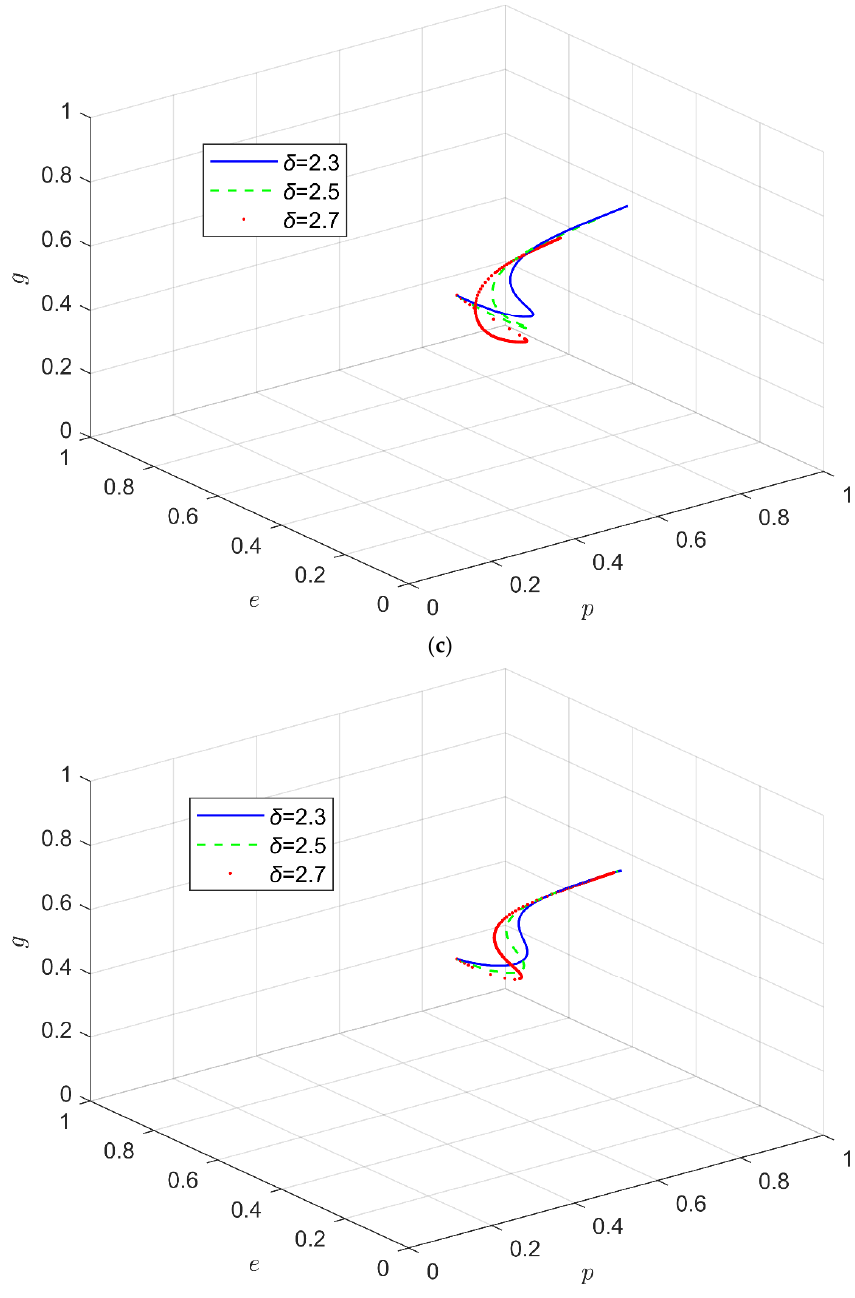
Figure 5. ( a ) Influence of loss avoidance coefficient on system evolution under static reward and static penalty system. ( b ) Influence of loss avoidance coefficient on system evolution under dynamic reward and static penalty system. ( c ) Influence of loss avoidance coefficient on system evolution under static reward and dynamic penalty system. ( d ) Influence of loss avoidance coefficient on system evolution under dynamic reward and dynamic penalty system.